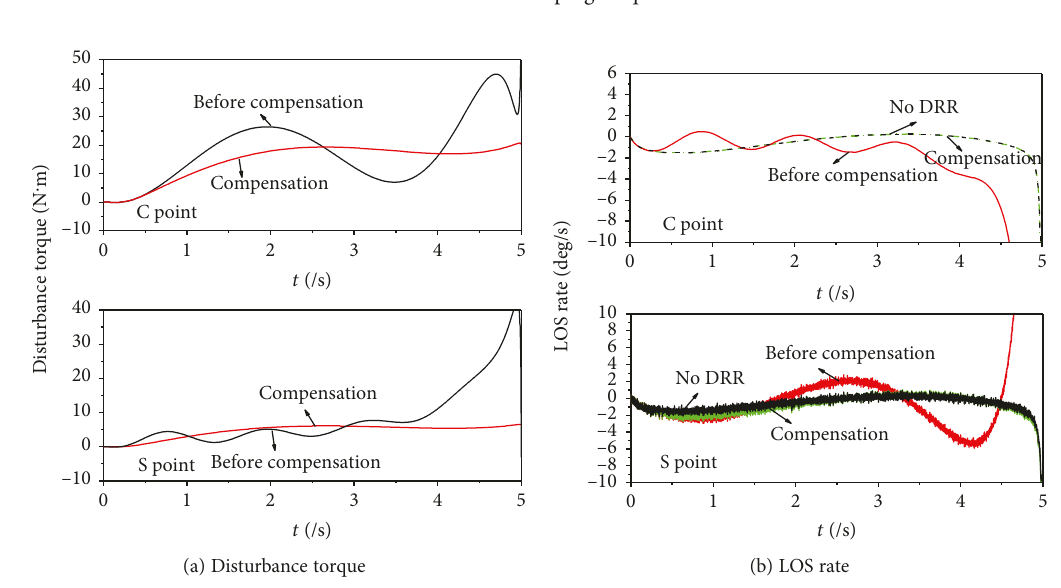
Figure 14: Damping